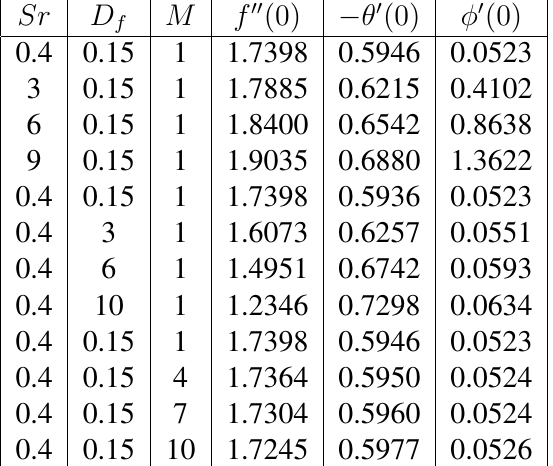
Table 1: Numerical data of f (cid:48)(cid:48) (0) , − θ (cid:48) (0) and φ (cid:48) (0) for Sr, D 0 . 22 , P r = 0 . 71 , λ k = 0 . 2 c